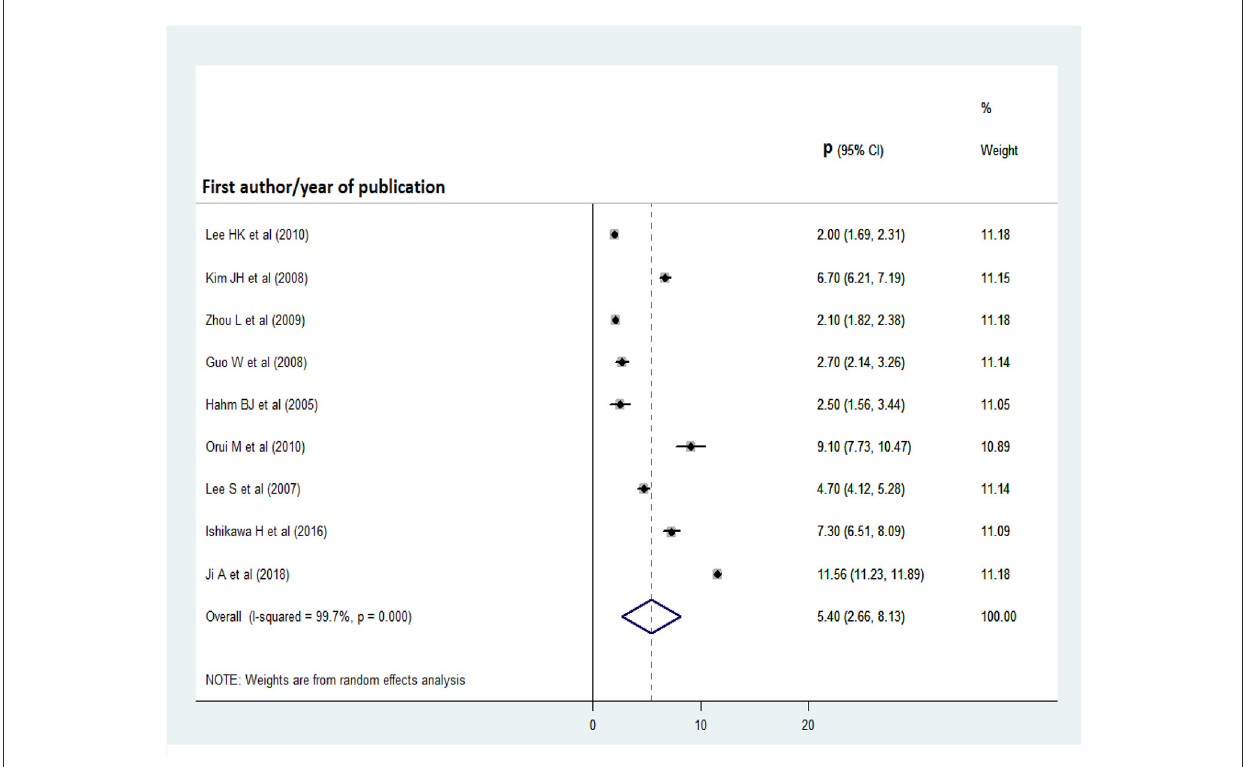
FIGURE6 Forest plot for the pooled prevalence of alcohol abuse.